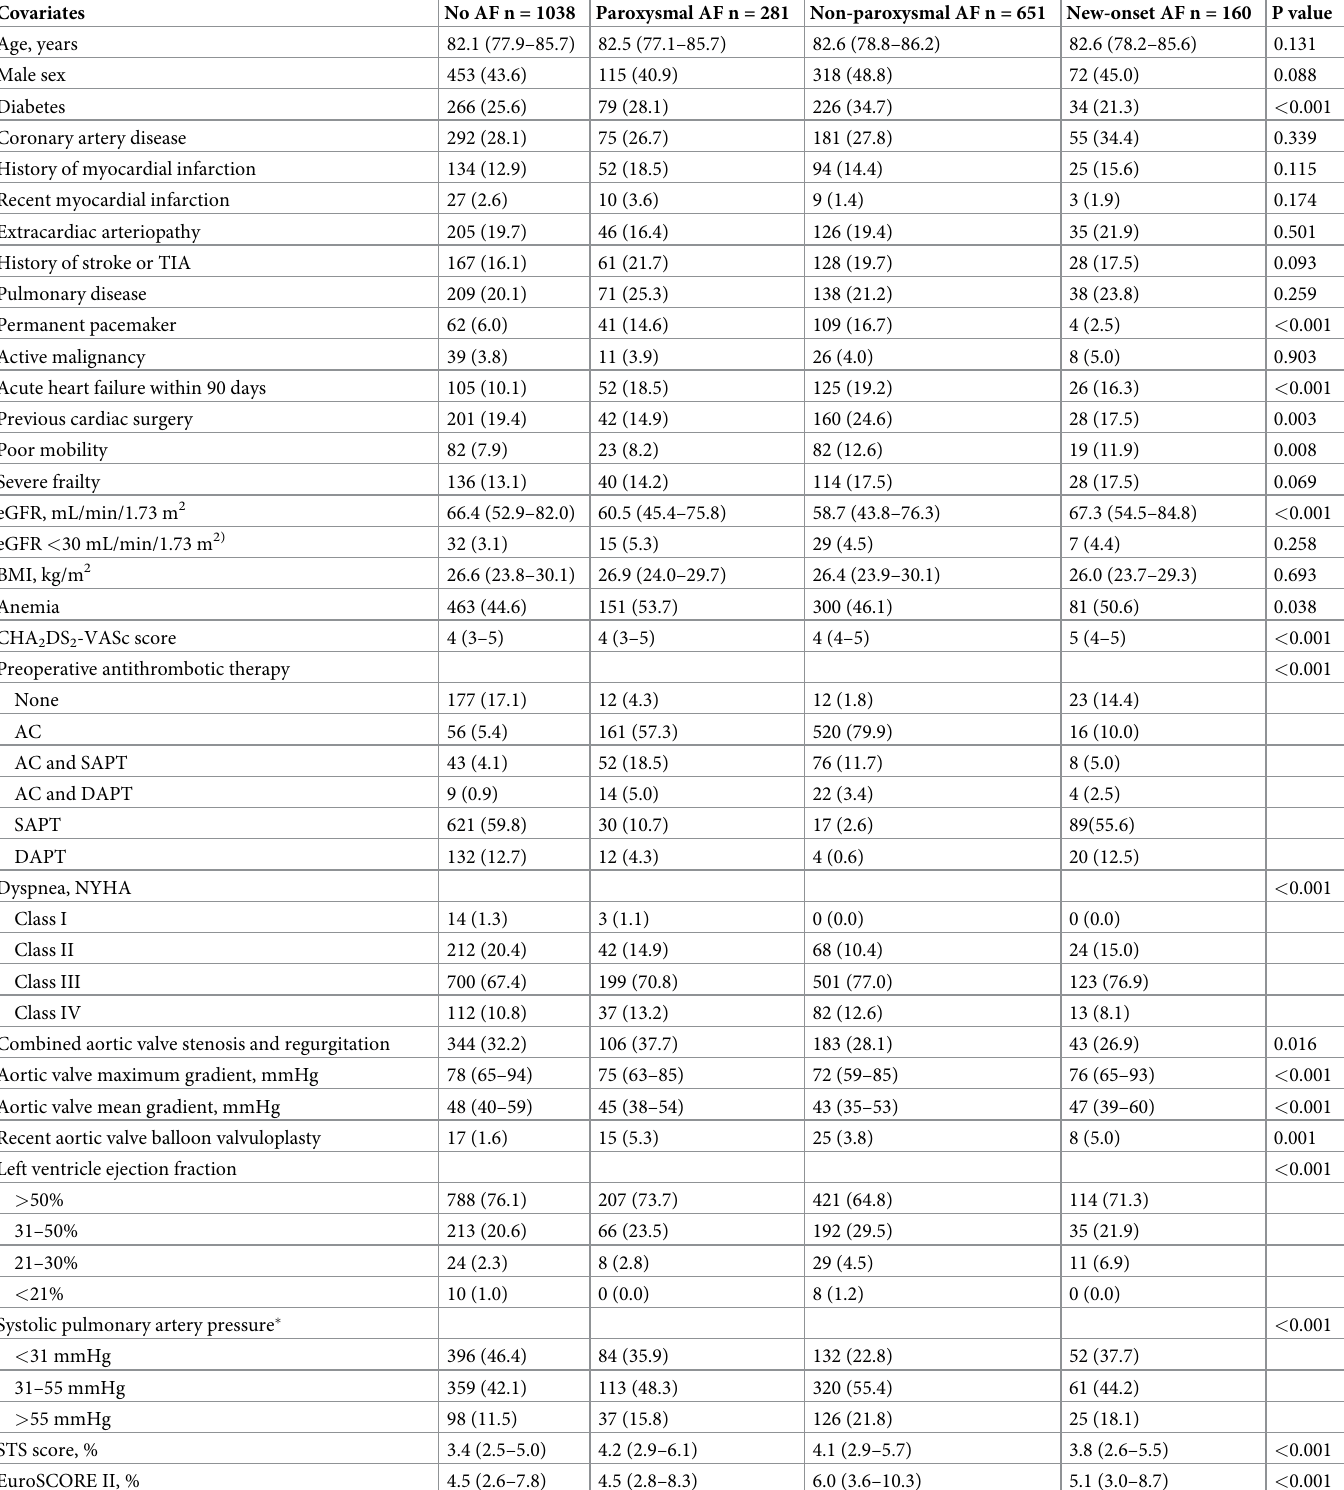
Table 1. Baseline and operative characteristics.